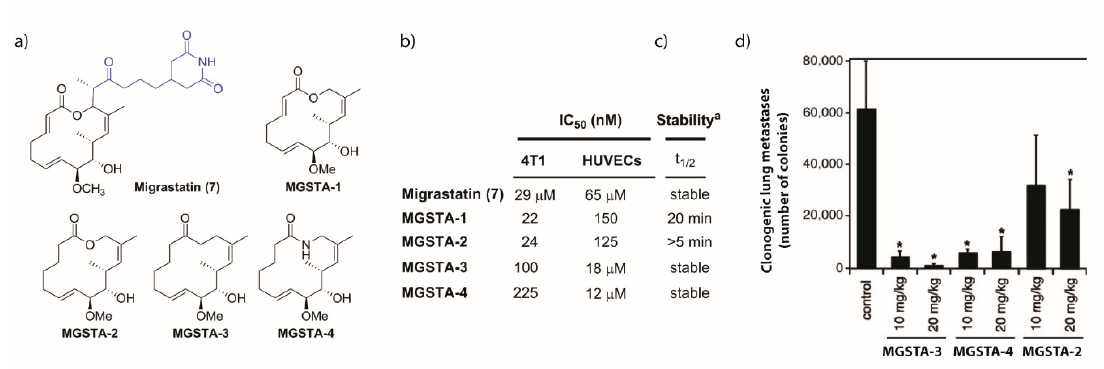
Figure 4. ( a ) Structures of migrastatin ( 7 ) and migrastatin analogs MGSTA-1 to 4 ; ( b ) Chamber cell migration assay with 4T1 mammary mouse tumor cells and HUVECs; ( c ) metabolic stability of migrastatin and analogs; ( d ) inhibition of breast tumor metastasis (4T1) by MGSTA-2 , MGSTA-3 , MGSTA-4 in a mouse model. Lung metastasis was measured by the 6-thioguanine clonogenic assay. Results are mean ± SD ( n = 5). * , p < 0.01. Adapted with permission from PNAS , 2005 , 102 , 3772. Copyright (2005) National Academy of Sciences, U.S.A. a Intensity of HPLC signal unchanged over 60 min of incubation.